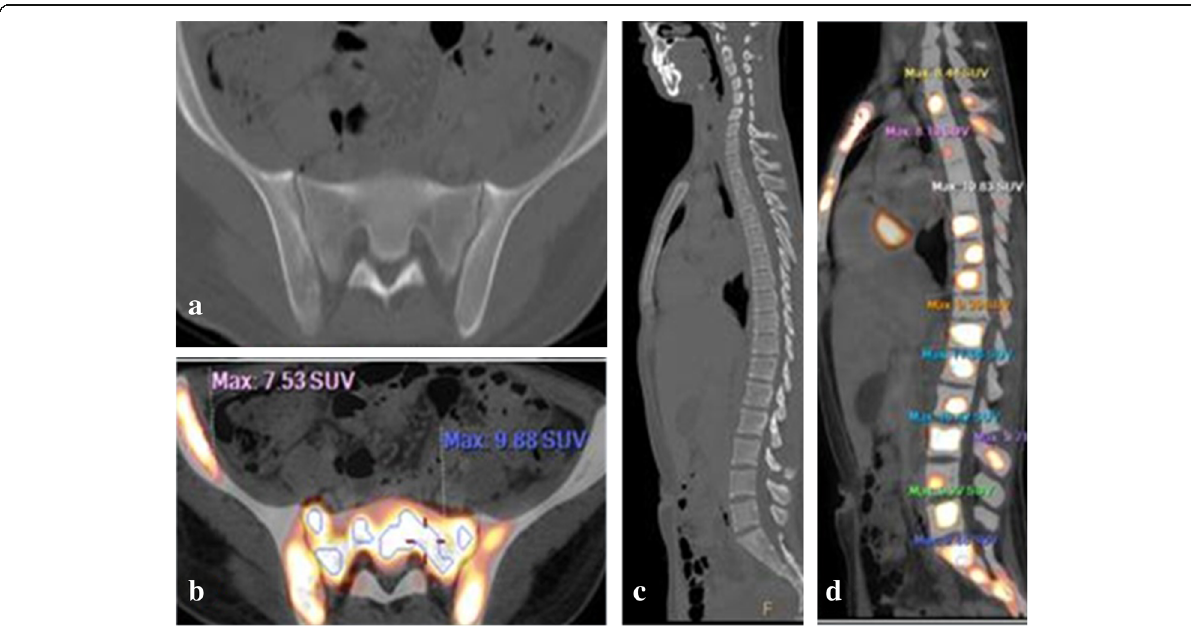
Fig. 8 a – d Hodgkin lymphoma cellular phase of nodular sclerosis ( a , c ) CT ( b , d ) fused PET/CT images showing hyper metabolic osseous lesions infiltrating the sacral ala, iliac bones ( b ) multiple vertebrae and sternum ( d ). The lesions were not detected in the diagnostic CT ( a , c